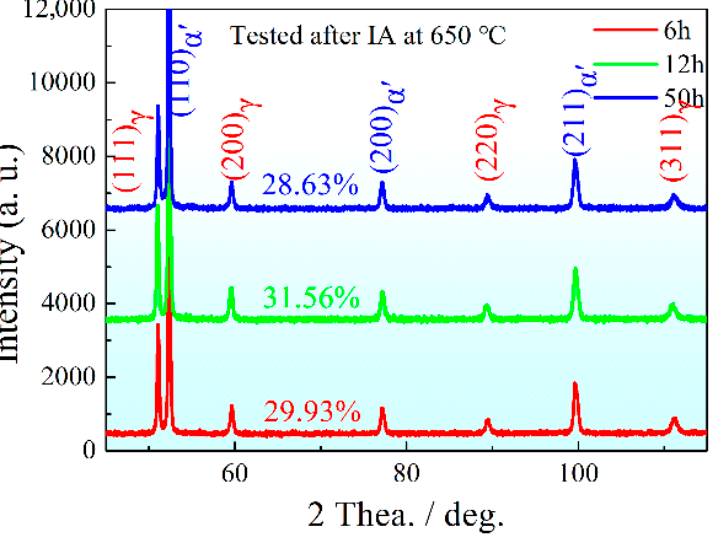
Figure 4. XRD line spectra after being intercritically annealed at 650 °C with different durations. The martensite lath substructure was observed by TEM as shown in Figure 5, and the lath-like PRA with some stacking faults was embedded between lath martensite. With an increase in IA time, the martensite lath coarsened from about 147 nm at 6 h to about 273 nm at 50 h. With an increase in IA time, the martensite lath was coarsened due to the incorporation of martensite lath, which is consistent with the report by Xu et al. [22]. The dislocation density did not obviously decrease based on the image contrast [23]. It can be seen from Figure 5e–f that the obvious coarsened stage occurred at the edge of martensite lath or PRA after being tempered at 650 °C for 50 h, which potentially shows the phenomenon of α / γ interface reverse migration. Moreover, a large amount of round precipitation particles with sizes from 10 nm to 30 nm were uniformly distributed in a matrix.